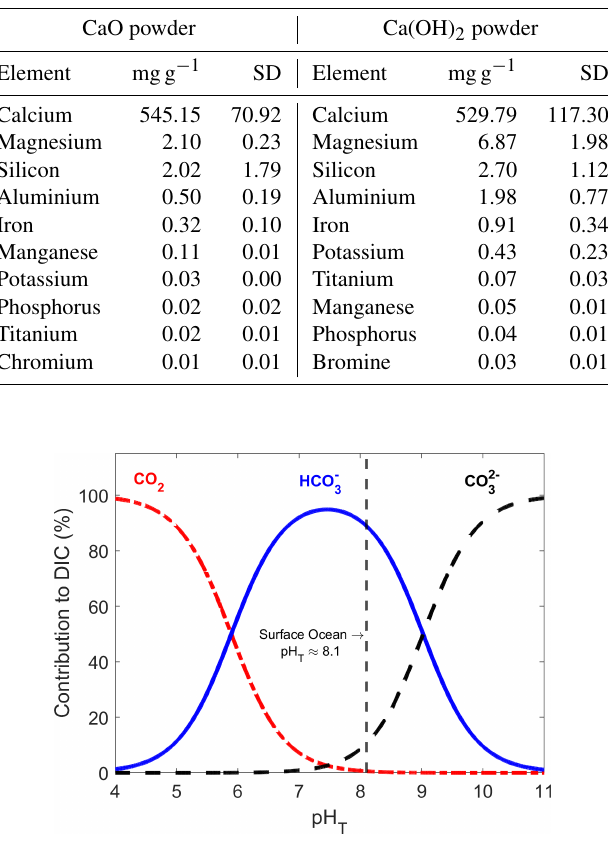
Figure A1. Relative contribution of dissolved CO 2 , HCO − (total scale), also known as a Bjerrum plot (based on the carbonic acid equilibrium constant from Mehrbach et al., 1973, and refitted by Dickson and Millero, 1987), at 25 ◦ C and a salinity of 35, with the current surface ocean pH average represented by the dashed vertical line (pH T ∼